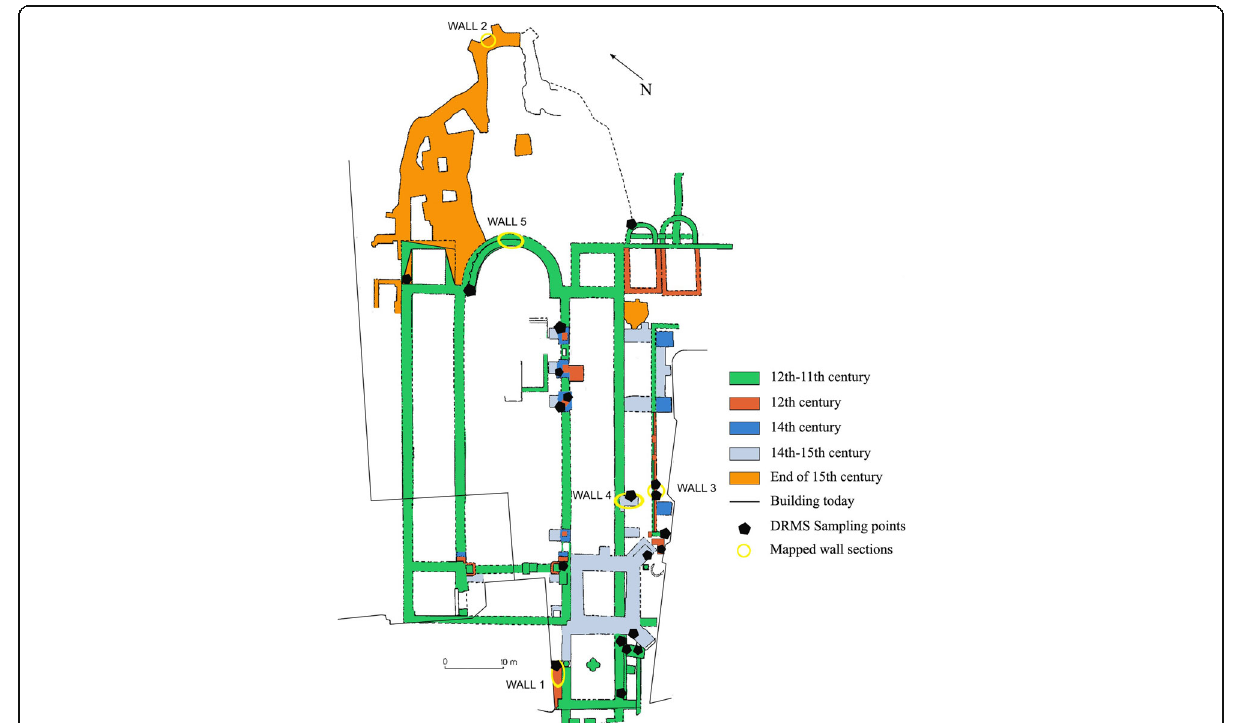
Fig. 2 Map of excavated ruins of the Székesfehérvár Ruin Garden depicting their different periods of construction and the main sampling points (modified after Bartos et al.